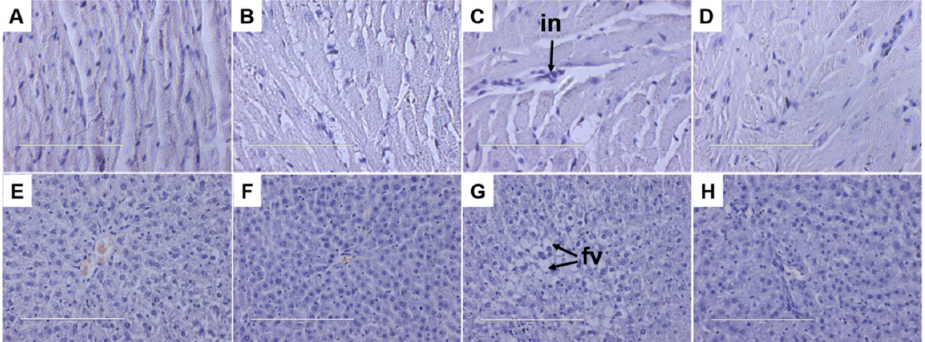
Figure 3. Effects of wasabi on heart inflammation and fat deposition in the liver. ( A – D ) Hematoxylin and eosin staining (40×) of the left ventricle showing infiltration of inflammatory cells (in) and ( E – H ) hematoxylin and eosin staining of the liver showing fat vacuoles (fv) from corn starch diet-fed rats ( A , E ), corn starch diet-fed rats supplemented with wasabi ( B , F ), high-carbohydrate, high-fat diet-fed rats ( C , G ) and high-carbohydrate, high-fat diet-fed rats supplemented with wasabi ( D , H ). Wasabi extract has been shown to decrease inflammatory mediators such as cycloox- Along with obesity, wasabi normalised the systolic blood pressure in HW rats. ygenase-2, inducible nitric oxide synthase and cytokines such as IL-6, IL-1 β , interferon γ and tumour necrosis factor [10,45,46], plasma adiponectin concentration, and expressions of acetyl-CoA carboxylase, fatty acid synthase, 3-hydroxy-3-methylglutaryl-coenzyme A reductase, CCAAT-enhancer-binding proteins, PPAR γ and SREBP-1c in liver and adipose tissue [12]. This study has demonstrated a reduction of inflammatory cell infiltration in the heart of obese rats treated with wasabi. Allyl isothiocyanate and Wasabia koreana (a related species to wasabi) have shown anti-inflammatory effects in colitis and irritable bowel syndrome mice models [47–49]. Further, wasabi components including 6-MSITC have been shown to have anti-inflammatory effects through different mechanisms includ- ing inhibition of NF- κ B pathway [10,47,50].